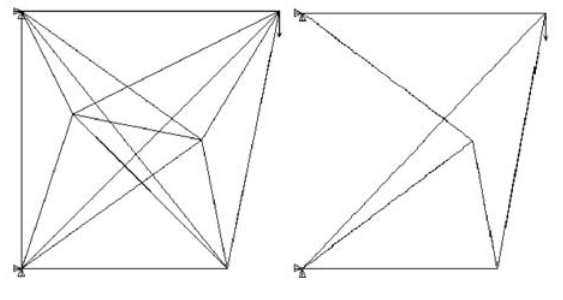
Fig. 4. 6-node truss system and the best solution